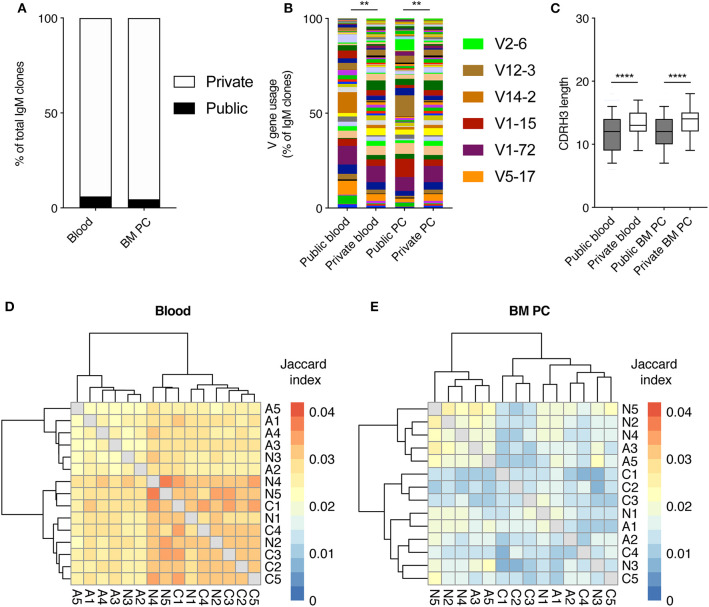
Minor but distinct profile of public clones across all infection cohorts. (A) The percentage of pooled blood or BM PC IgM clones either private (found in only 1 mouse) or public (found in more than one mouse). (B) V gene usage of public clones and private IgM clones from pooled blood and BM PC repertoires. (C) Amino acid CDRH3 length of public and private clones from pooled blood and BM PC repertoires. (D) Pairwise Jaccard index quantifying clones found in the pooled blood repertoires of the indicated two mice. Labels correspond to infection cohort (N = uninfected, A = acute infection, C = chronic infection) and number corresponds to a distinct mouse within the cohort. Intensity corresponds to the number of clones common to both repertoires divided by the number of unique clones found in either repertoires. Sample order and accompanying dendrograms were determined via hierarchical clustering. (E) Pairwise Jaccard index as in D but quantifying clones found in the BM PC repertoires of multiple mice. **p ≤ 0.05, ****p ≤ 0.0005, not significant (n.s.) p > 0.05.